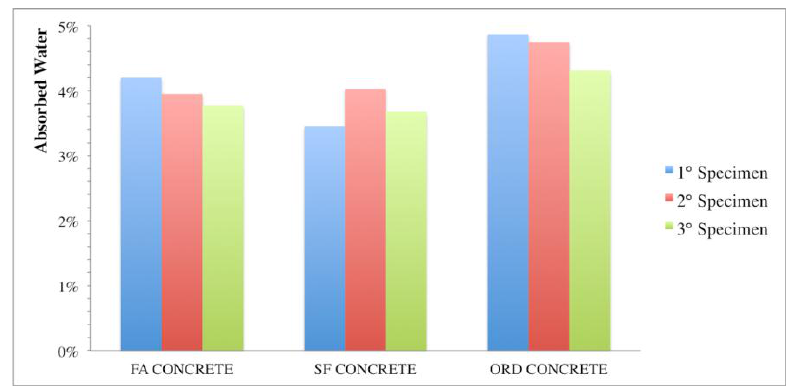
Figure 6. Percentage of water absorbed by the specimens.